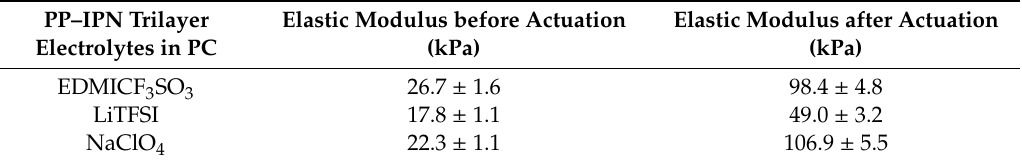
Table 2. Elastic modulus of PP–IPN trilayers before and after actuation cycles.